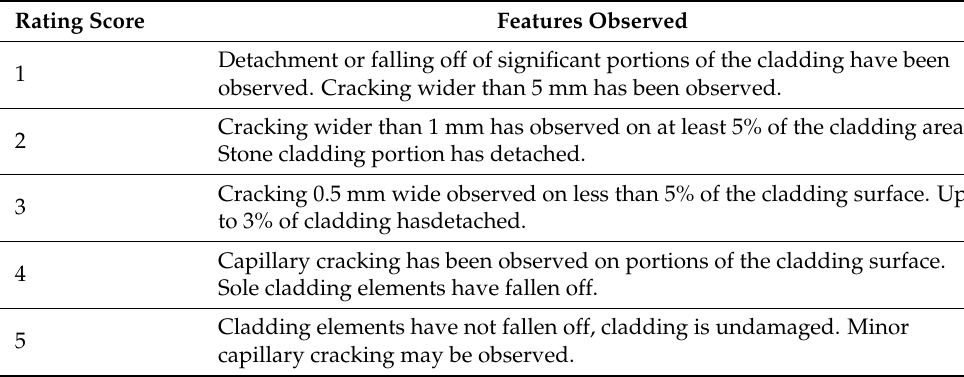
Table 1. Physical rating score, Shohet and Paciuk [12].